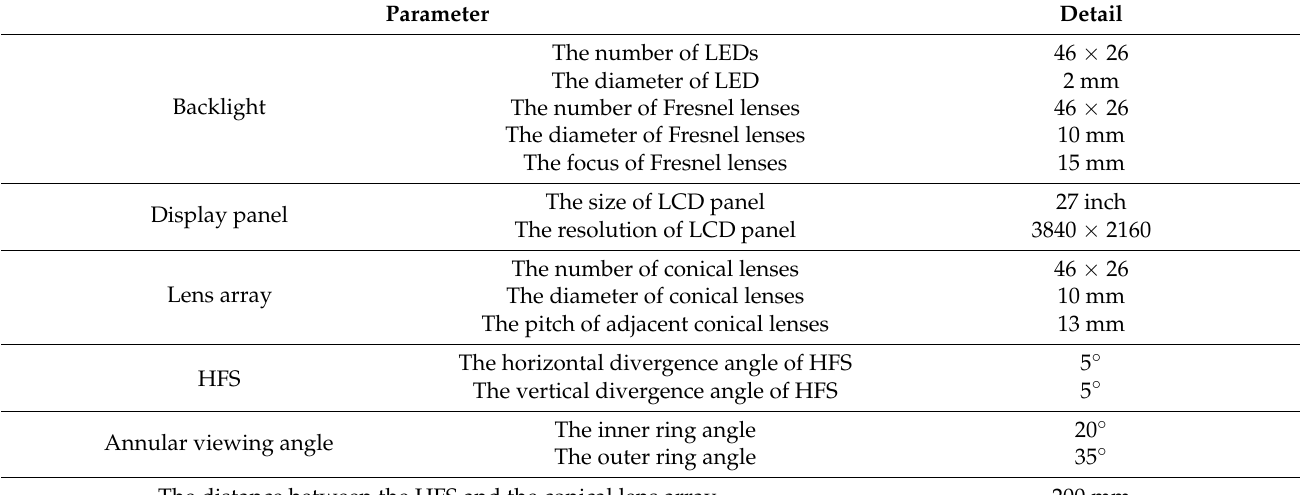
Table 1. The specific parameters of tabletop 360-degree 3D light-field display system.